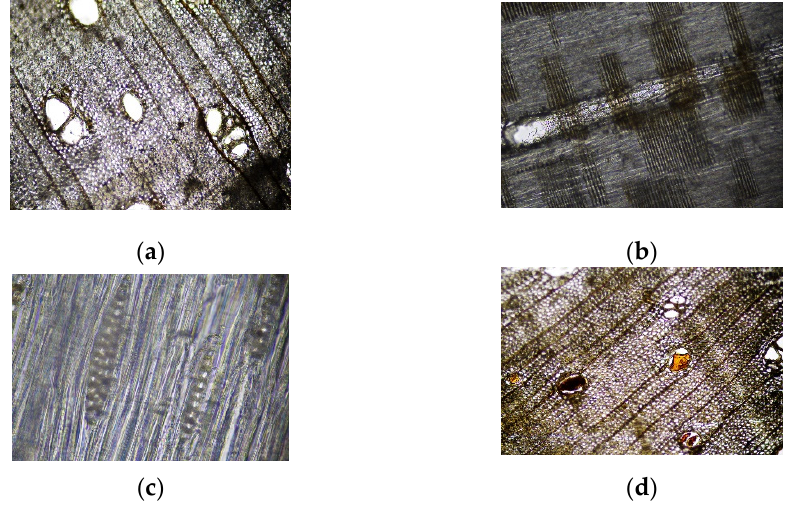
Figure 1. Optic microscope pictures of Gt : ( a ) sapwood tangential cut 10×; ( b ) sapwood radial cut 10×; ( c ) sapwood transversal cut 40×; ( d ) heartwood transversal cut 10×. E. camaldulensis has a calorific value of 19.2 MJ/kg [24], higher than that of Gt sap-